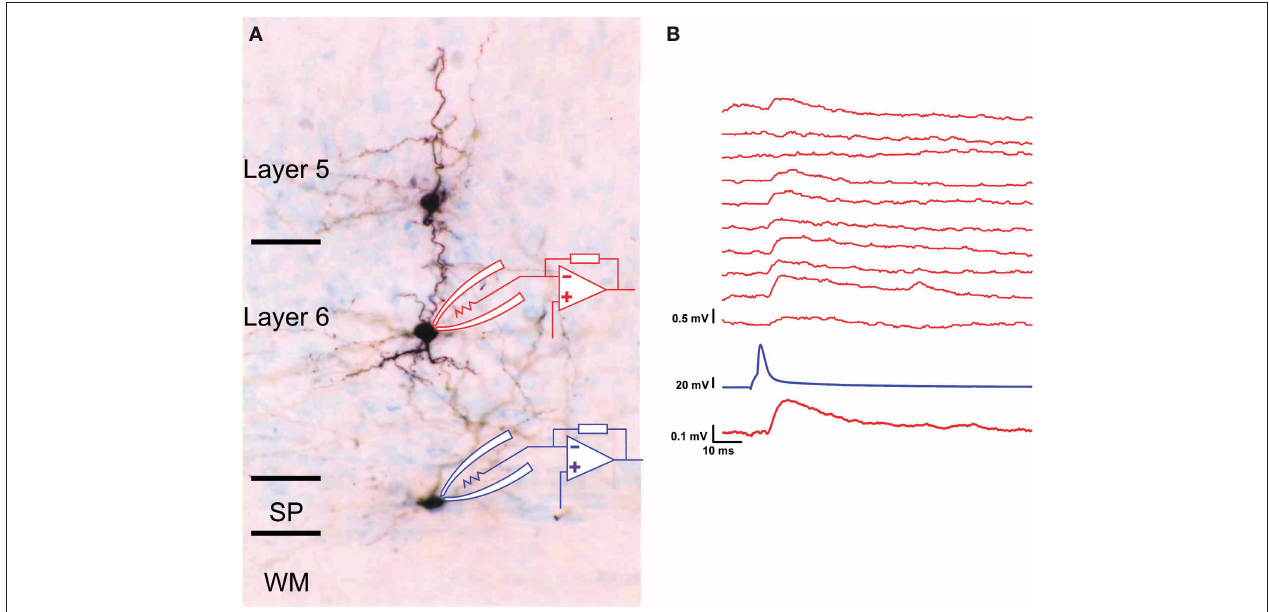
FIGURE 5 | Functional synaptic connections between SP and layer 6 neurons. (A) Photomicrograph of the brain slice preparation where three cells were patched, recorded and tested for synaptic interactions. The lower cell located in the subgriseal area (SG) of the subplate at the bottom of layer 6 functionally innervated the layer 6 neuron above it (but not the layer 5 neuron above that). (B) The functional synaptic connection was ascertained through dual whole cell patch clamp electrophysiological recording where a single action